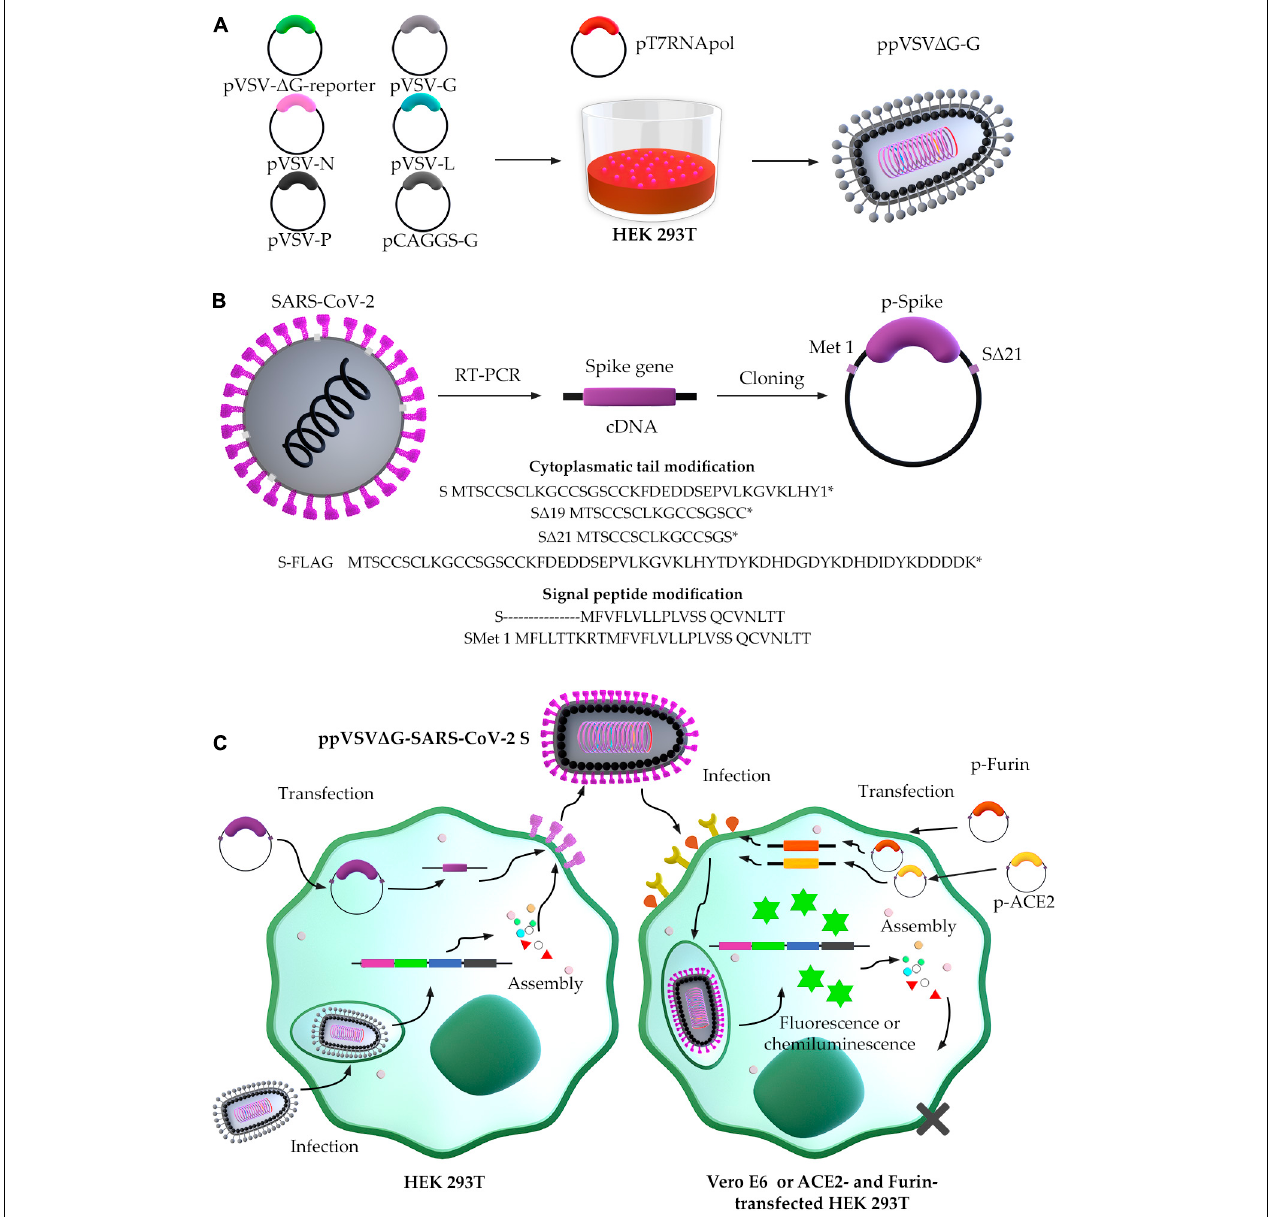
FIGURE 4 | Scheme of the generation of pseudotyped vesicular stomatitis virus-severe acute respiratory syndrome-coronavirus-2 (SARS-CoV-2) S. (A) Packaging of ppVSV. (B) Optimized conditions for cloning Spike gene. (C) ppVSV (cid:49) G-SARS-CoV-2 S assembly in HEK 293T cells, and infection assay in Vero E6 cells by ppVSV (cid:49) G-SARS-CoV-2